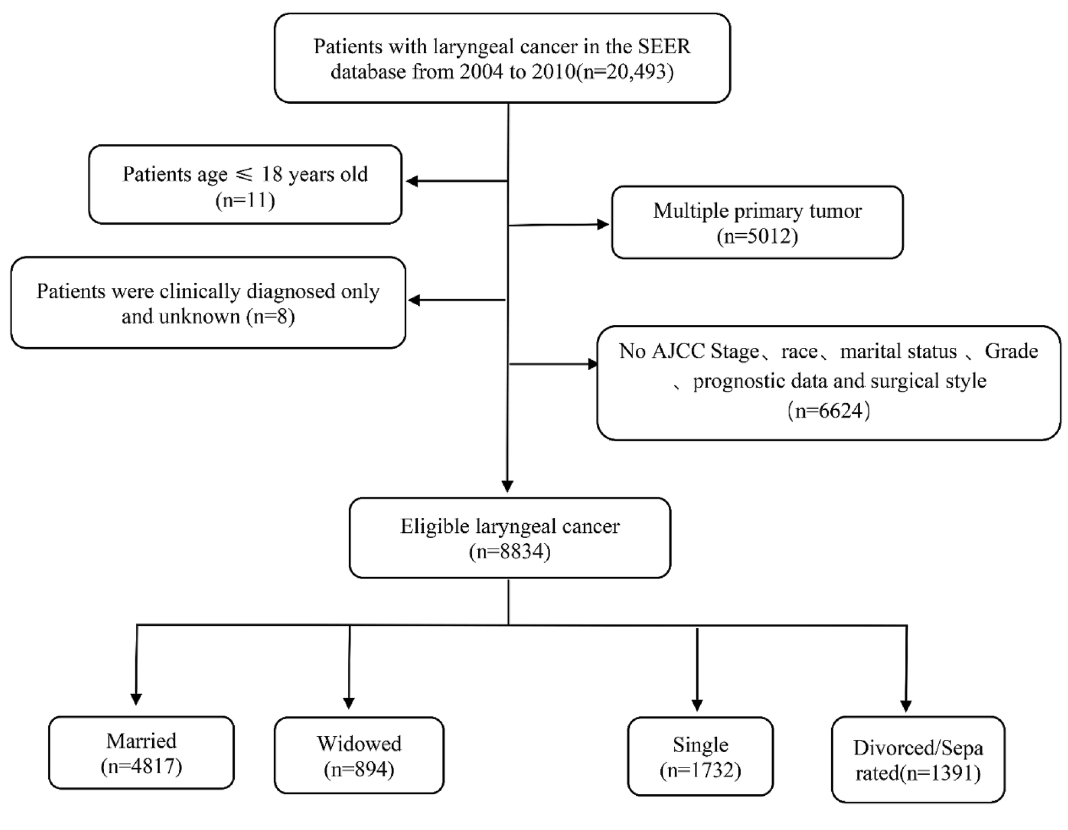
Figure 1. Flow chart for screening eligible